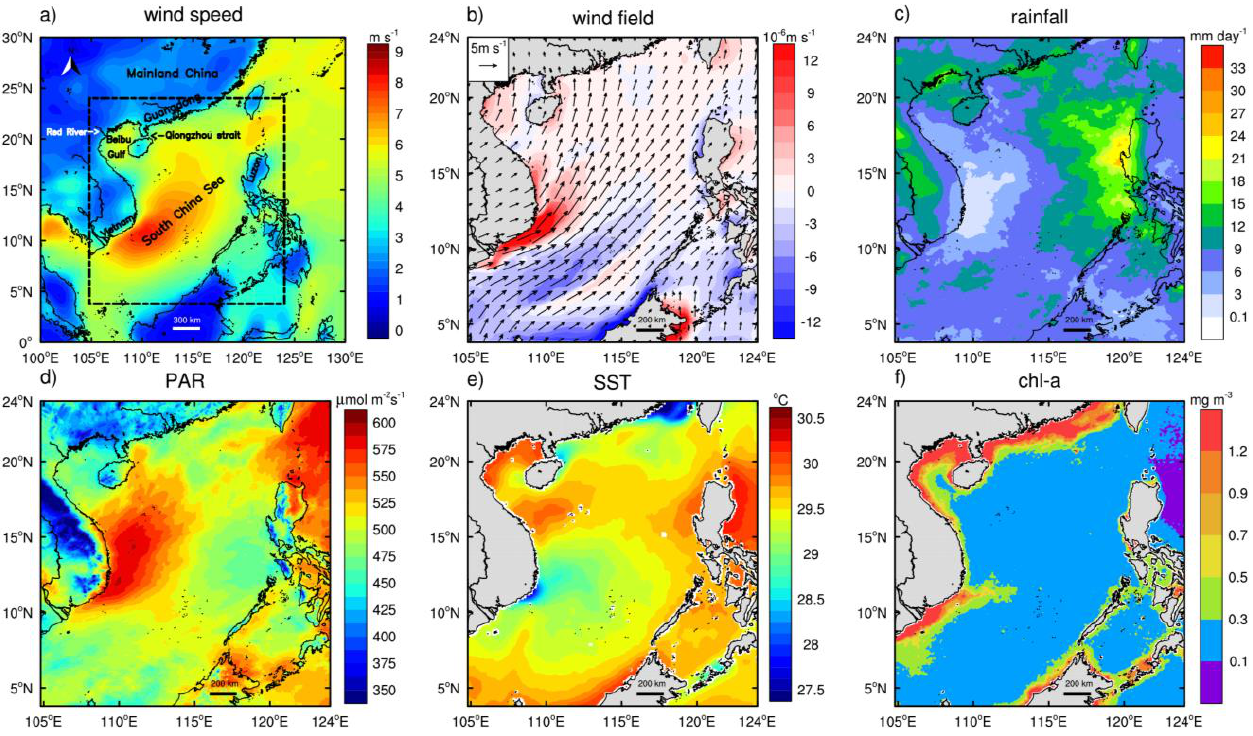
Figure 2. Average distribution of the hydrometeorological environment in summer, 2015 – 2018: ( a ) location map of the study area (black box), filled with wind speed; ( b ) wind fields at 10 m (arrows) and the Ekman pumping velocity (shaded, positive value is upwelling); ( c ) rainfall (shaded, mm day − 1 ); ( d ) PAR ( photosynthetically active radiation ) (shaded, μmol m −2 s − 1 ); ( e ) SST (shaded, °C); ( f ) chl-a concentration (shaded, mg m −3 ) [( b – f ) are in the black frame in ( a )].